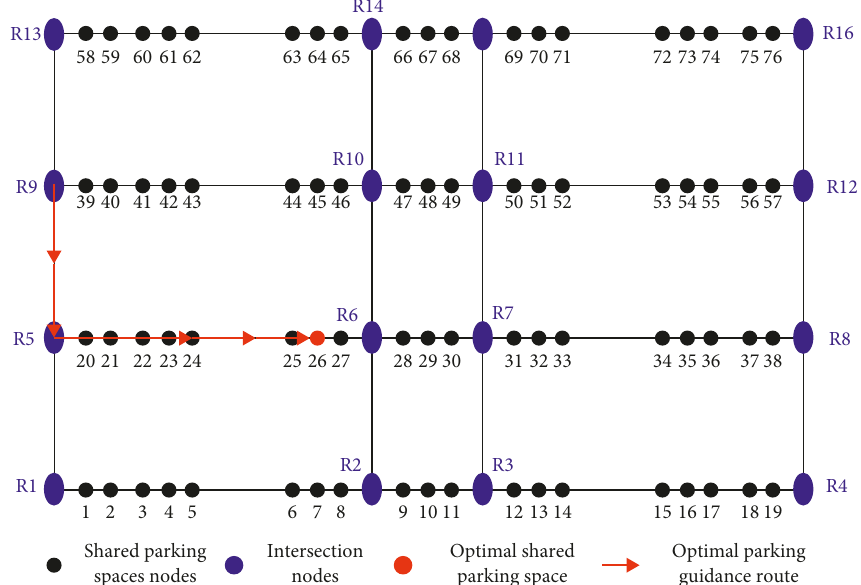
Figure 7: Topological network of shared parking spaces and the optimal parking route in the parking